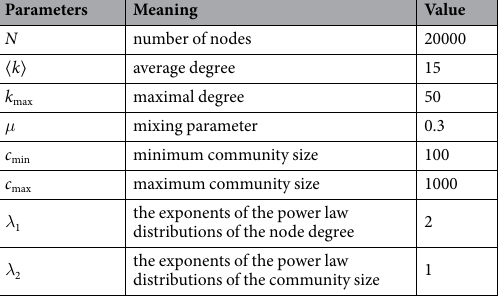
Table 1. Detailed information about the synthetic